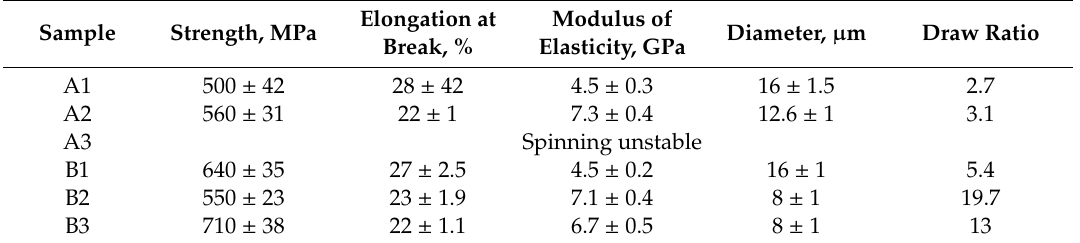
Table 5. Mechanical properties of fibers obtained from the copolymer solutions of series A and B.